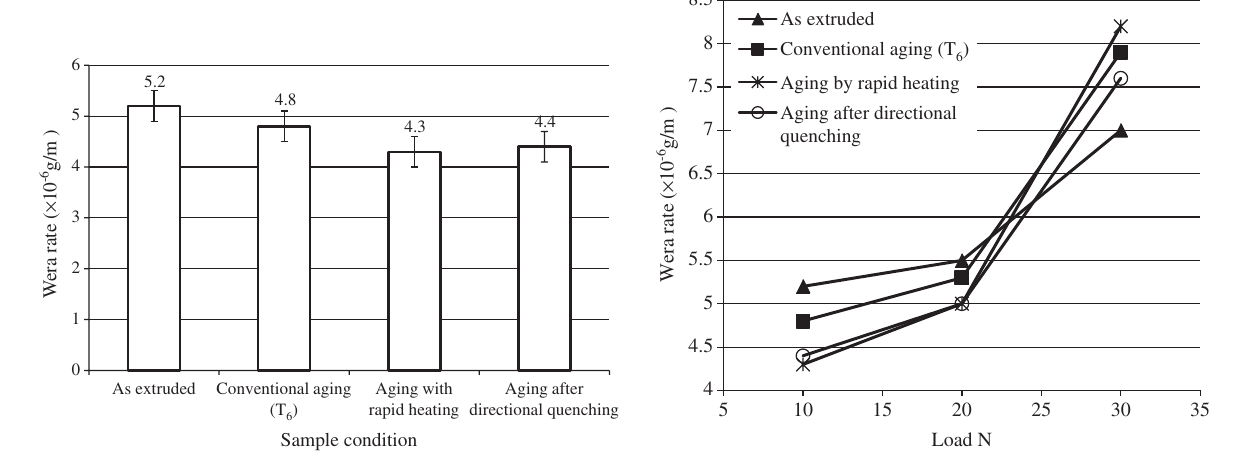
Figure 9: Results of wear rate of AA8090/6% SiC different conditions at 10 N load.